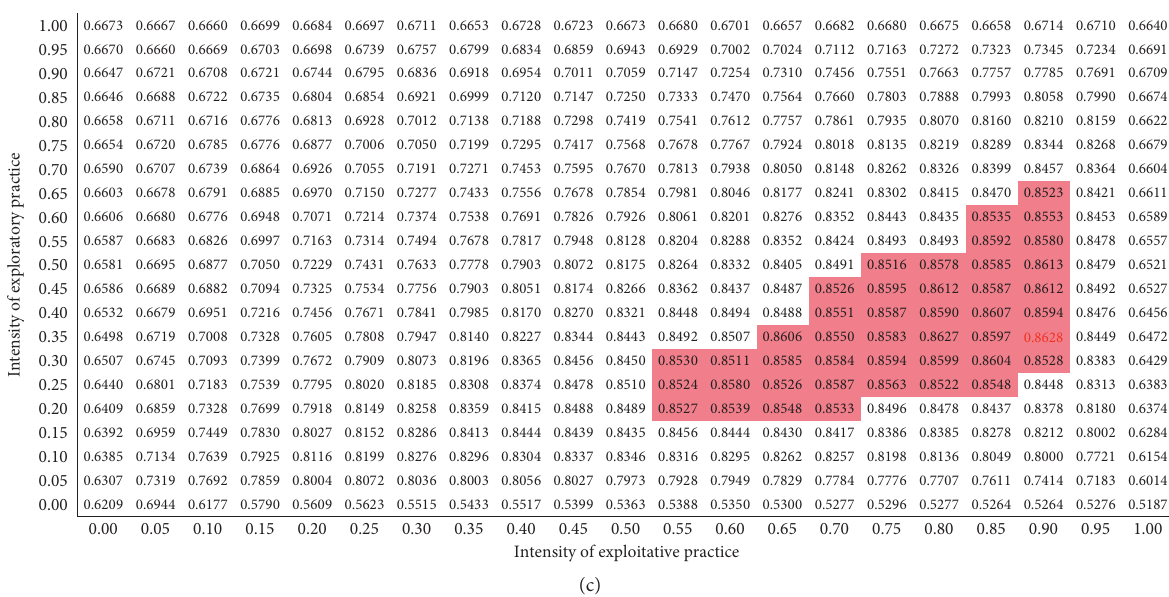
Figure 5: Effect of absorptive capacity on organizational adaptability and practice strategy. (a) p